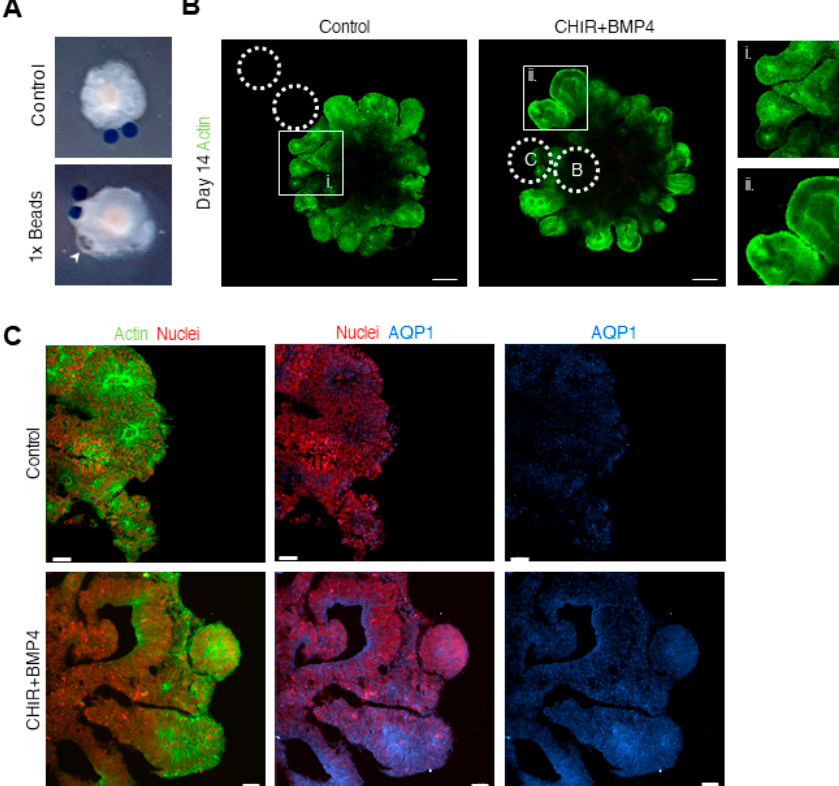
Figure 3. Liquid-filled cysts and larger ventricles are observed in the 1× condition. ( A ) Day 14 control and 1x condition organoids. A white arrow shows a liquid-filled cyst. ( B ) Live-imaging of day 14 control and 1x condition organoids showing LifeAct-GFP (green). Scale bars 200 μ m. (i,ii) Enlarged captions of (i) control and (ii) 1× CHIR + BMP4 condition, showing the NE centers and the ventricle